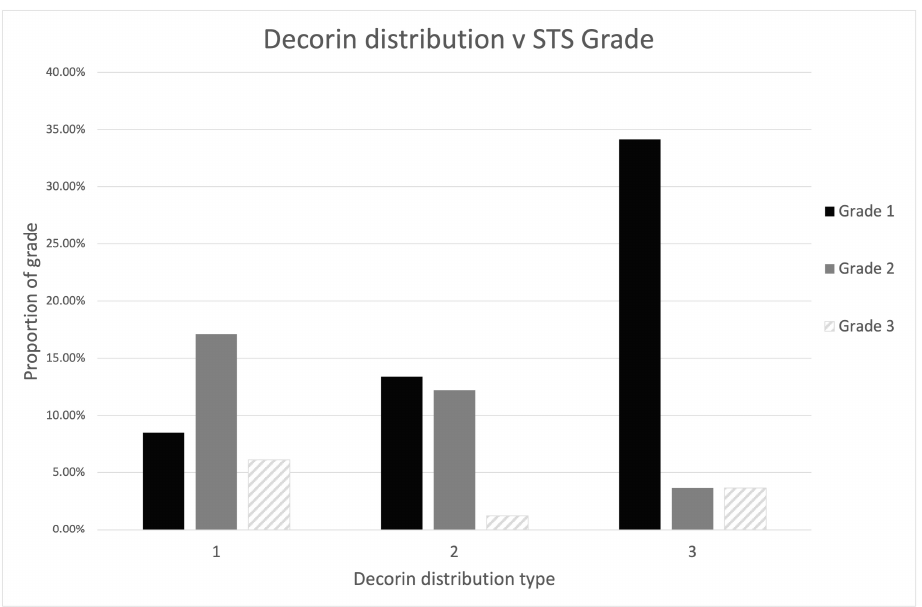
Figure 7. Distribution of decorin immunostaining pattern according to tumour grade. Low-grade tumours were more likely to have a type 3 decorin pattern.